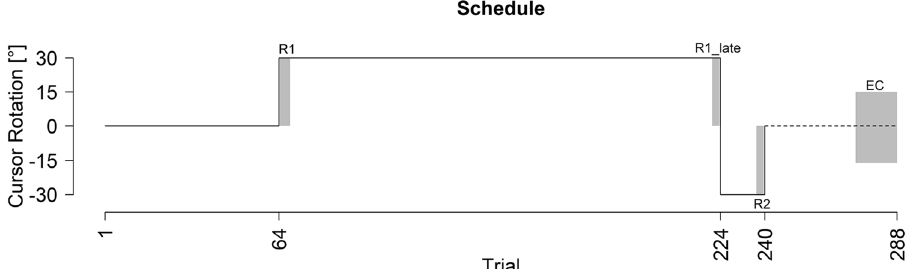
Figure 6. Experimental Schedule. Participants reached to visual targets with a perturbation denoted by the black line. The dotted line at the end of the paradigm signifies clamp trials where there was no visual error as the cursor always moved to the target regardless of the participants movement direction. Trials included in analysis are as follows: R1 = trials 65–68; R1_Late = trials 221–224; R2 = trials 237–240; EC =